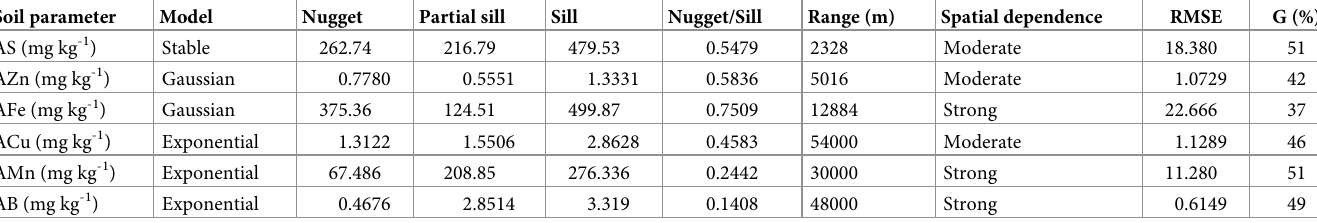
Table 4. Semivariogram attributes of soil parameters of cultivated areas of coastal India. Soil